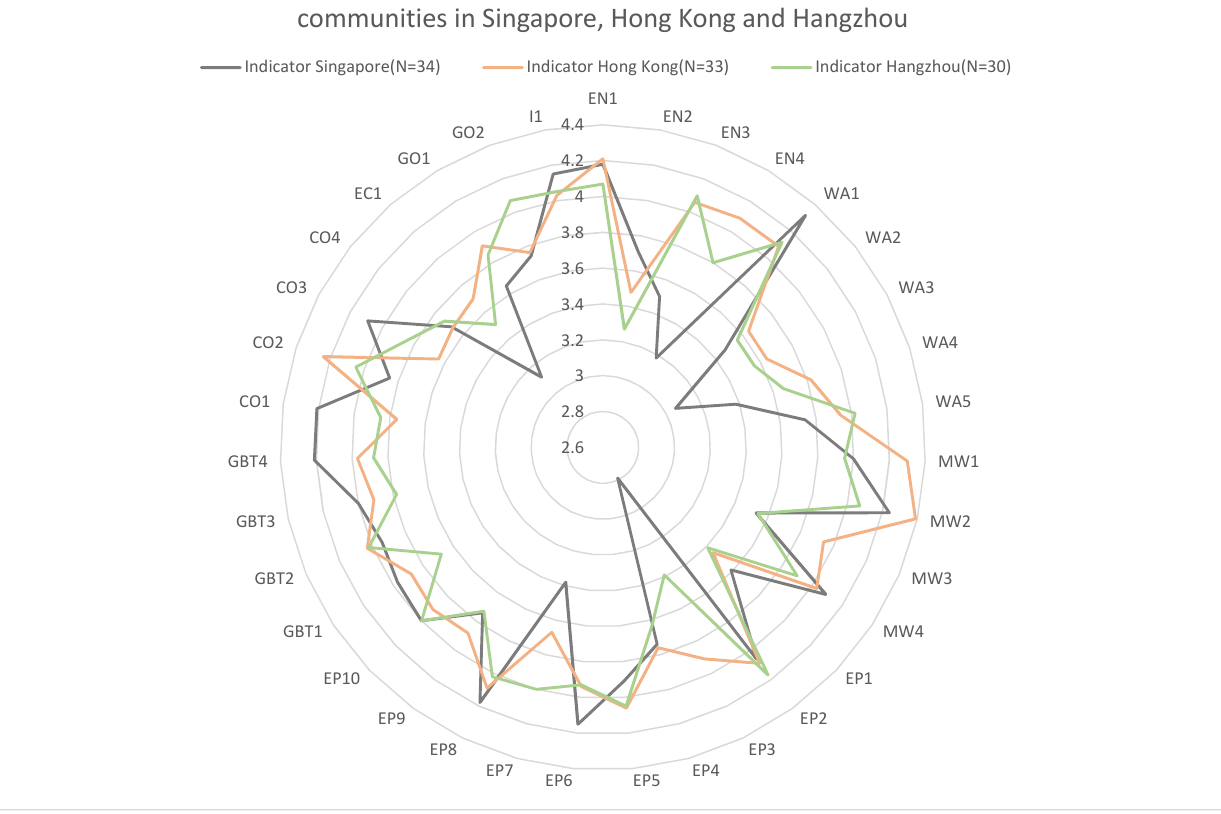
Figure 2. Comparison of the significance level of the preliminary elements of attentions for enhancing urban resilience in Singapore, Hong Kong and Hangzhou.